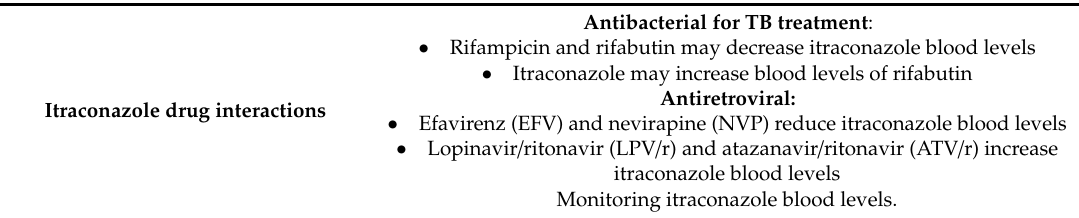
Table 1. Recommendation for treatment of histoplasmosis in persons living with HIV